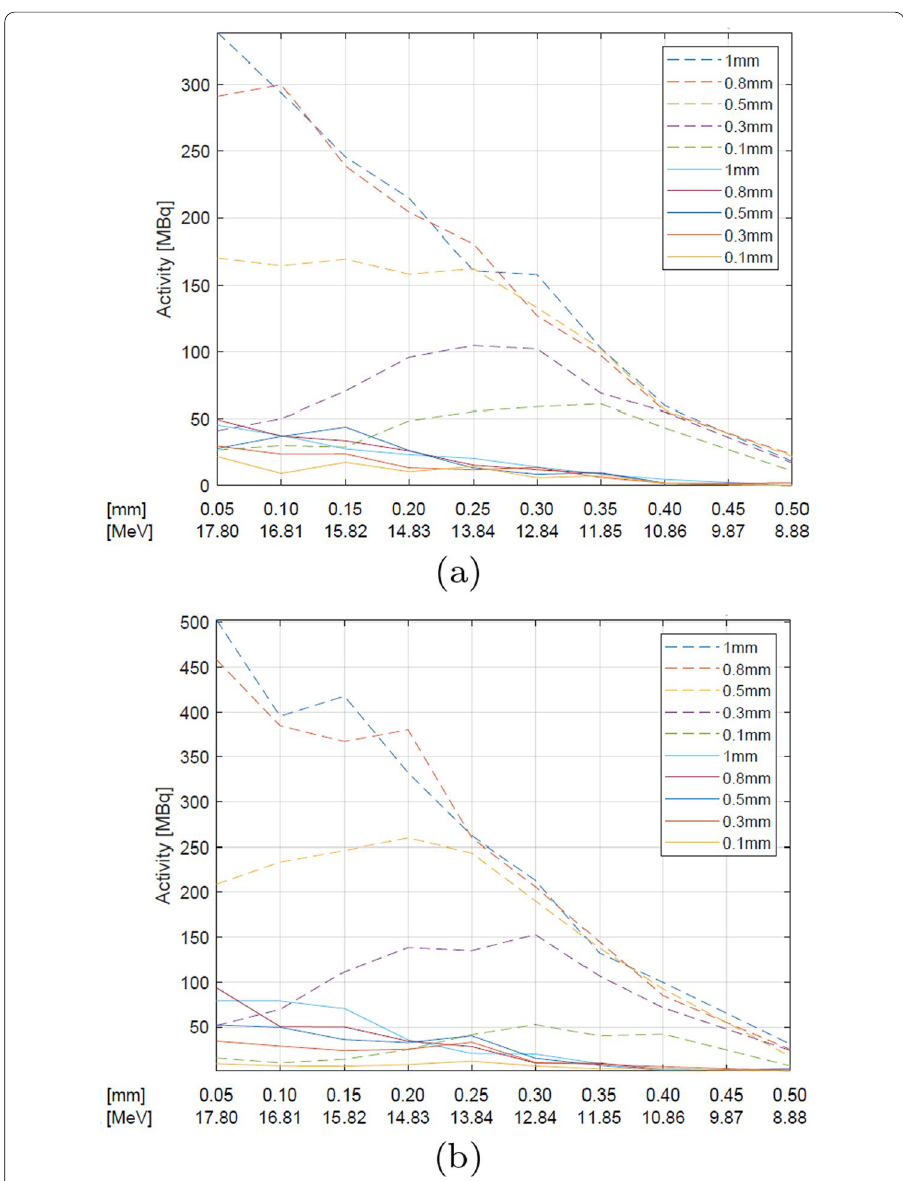
Fig. 5 The simulated activity changes of 124 I from natural (straight line) and enriched (dashed line) TeO 2 for various target thicknesses (denoted by various colors as shown in the legend) and various Havar foil thicknesses at the proton current of a 10 μA and b 15